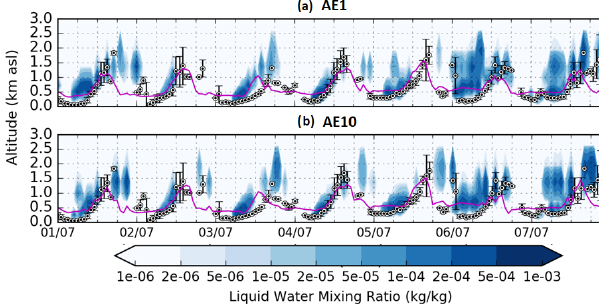
Figure 7. Cloud base height at Savè (Benin) measured with the ceilometer (the black circles represent the hourly averages and the bars represent the hourly standard deviation), and compared to the modeled vertical distribution (blueish color shading) of liquid wa- ter mixing ratio (kgkg − 1 ) interpolated at Savè in Benin (8.03 ◦ N, 2.49 ◦ E) for the two experiments (a) AE1 and (b) AE10, with the modeled planetary boundary layer height (violet